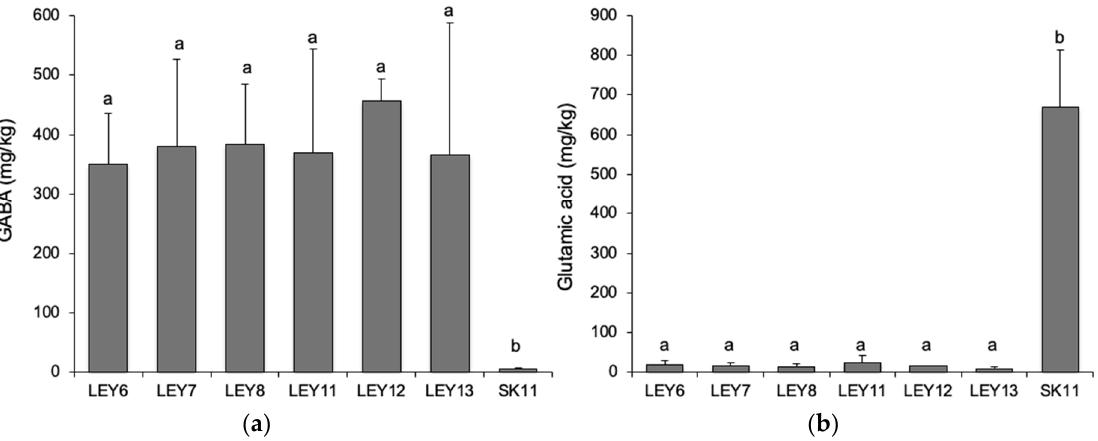
Figure 4. ( a ) GABA and ( b ) glutamic acid accumulation (mg/kg) in Cabrales-like experimental cheeses made using the L. lactis strains individually as starter cultures. Bars with different letters indicate significant differences in GABA or glutamic acid accumulation ( p < 0.05) compared to control cheeses made with the non-GABA producing strain L. lactis SK11.